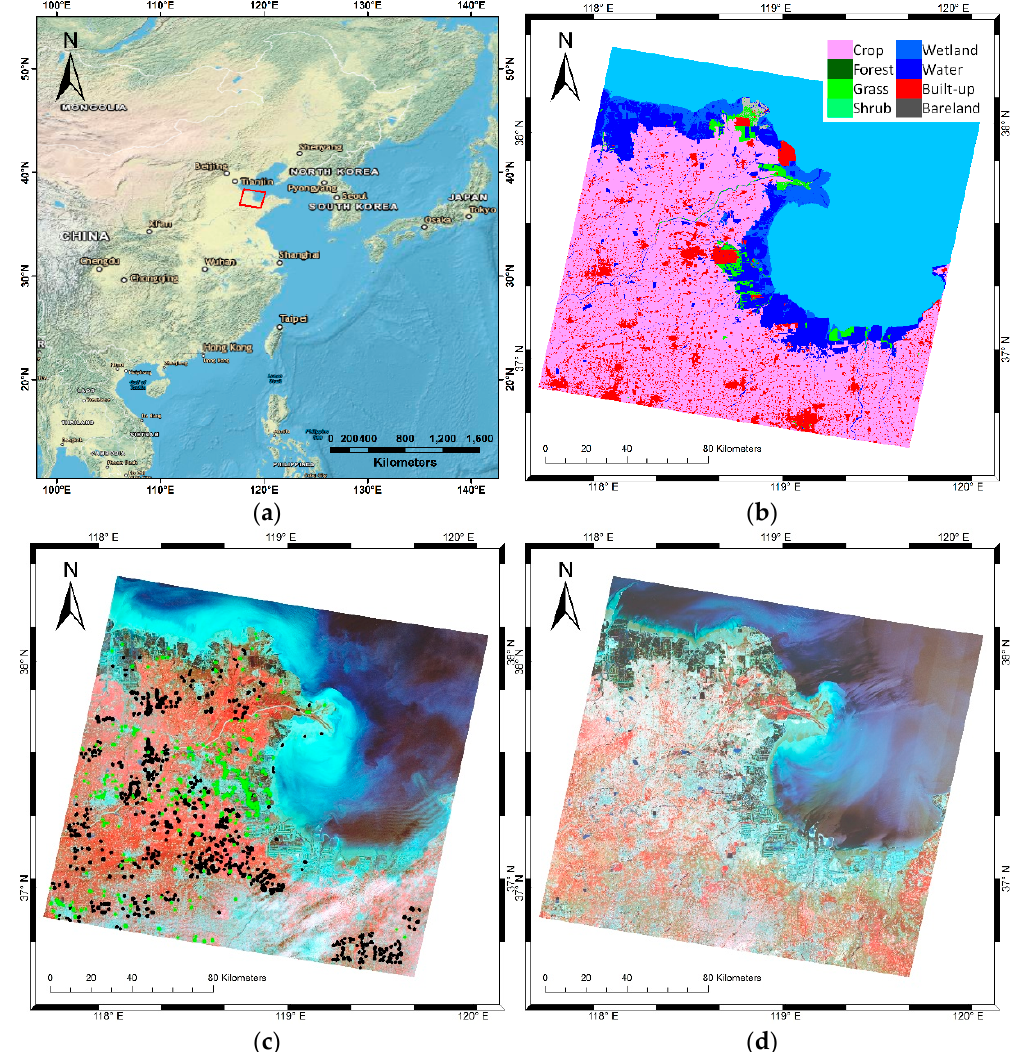
Figure 3. The location, land covers, Landsat images and ground truth points of the study area. ( a ) The location of the study area (red) in the reference map. ( b ) The land covers of the study area in year 2010, which were extracted from the Globeland30 dataset (www.globeland30.org). ( c ) TM image acquired on 28 April 2010, where the black dots are the 2100 ground points with land cover conversions and the green dots are the 2523 ground points with no land cover conversions. ( d ) The OLI image acquired on 19 January 2015.